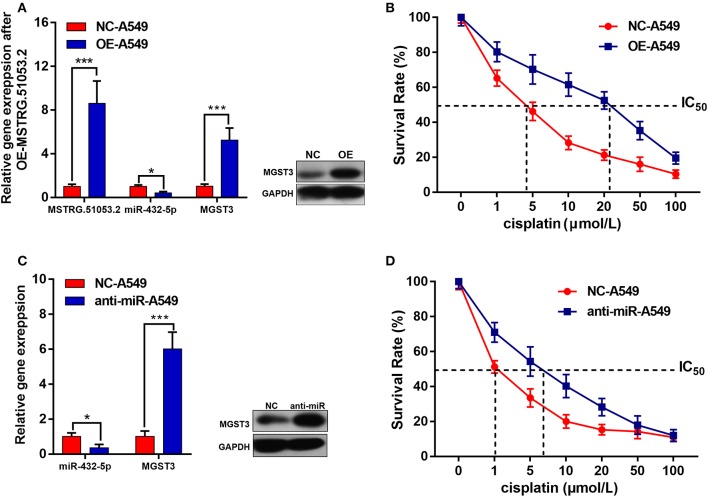
(A) The expression levels of MSTRG510532, miR-432-5p and MGST3 after transfection with full-length MSTRG.51053.2 cDNA. (B) The IC50 value of cisplatin in the A549 cells overexpressing MSTRG.51053.2 were significantly higher than that in the control group. (C) The expression levels of miR-432-5p and MGST3 after transfection with miR-432-5p inhibitor. (D) The IC50 value of cisplatin in the A549 cells treated with miR-432-5p inhibitor was significantly higher than that in the control group. *P < 0.05, ***P < 0.001.